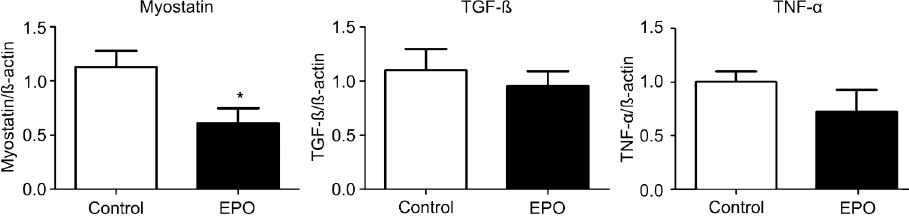
Figure 2. Myostatin, transforming growth factor beta (TGF- b ), and tumor necrosis factor alpha (TNF- a ) gene expression in the left quadriceps of treated (EPO) and control mdx mice. *P , 0.05, GBStat